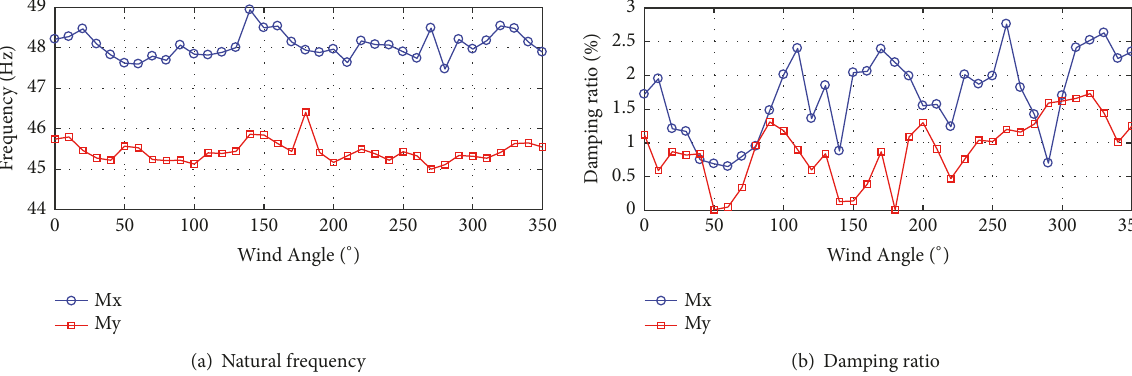
Figure 7: The identified dynamic parameters of the model-balance system of Guangzhou East Tower under different wind directions before